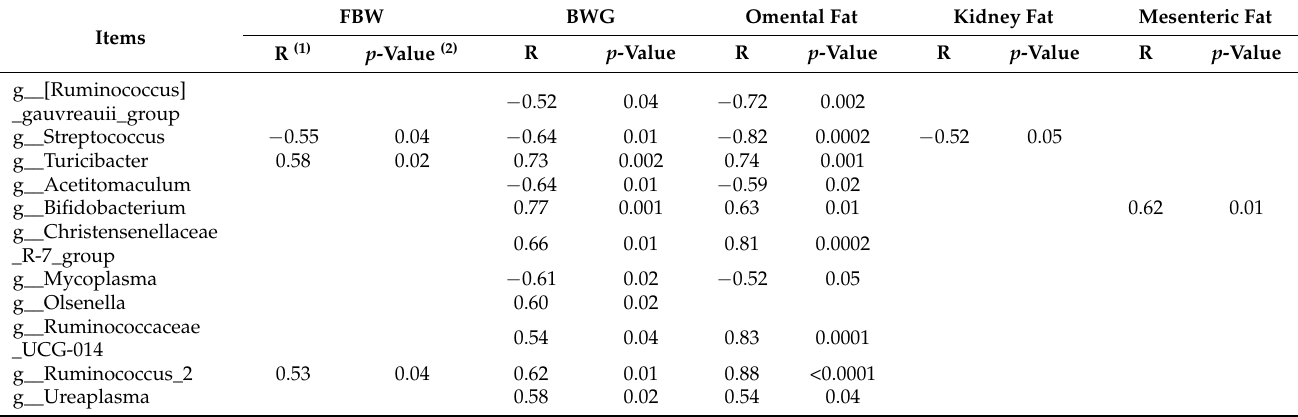
(1) Spearman correlation coefficient (R) represents the degree of association between ileum bacterial community and growth performance, lipid deposition. (2) Correlations with p ≤ 0.05 for the linear model were considered as significant. FBW: final body weight; BWG: total body weight